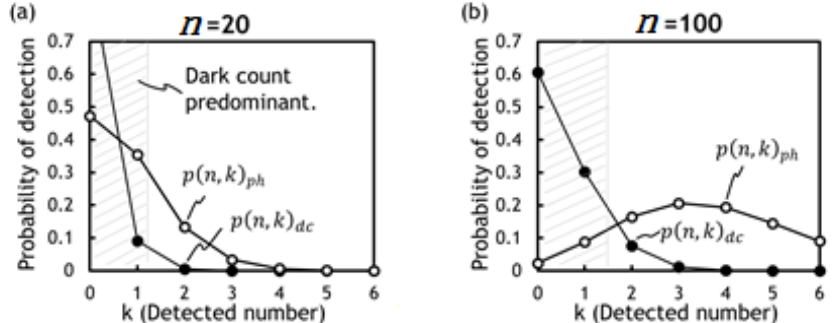
Figure 4. Light pulse and dark count detection probabilities for n = 20 ( a ) and for n = 100 ( b ). The hatched areas are dark count predominant regimes. As n increases from 20 to 100, both curves of p(n,k) ph and p(n,k) dc shift towards right. However, p(n,k) ph peaks at 3 meaning that 3 photon pulses are accumulated out of 100 pulses. On the other hand, dark count pulses peak at 0 with probability 0.6 and its detected probability at 3 pulses is less than 0.05. Therefore, by setting a threshold signal level of 3 pulses, the signal corresponding to photons reflected from an object is extractable.